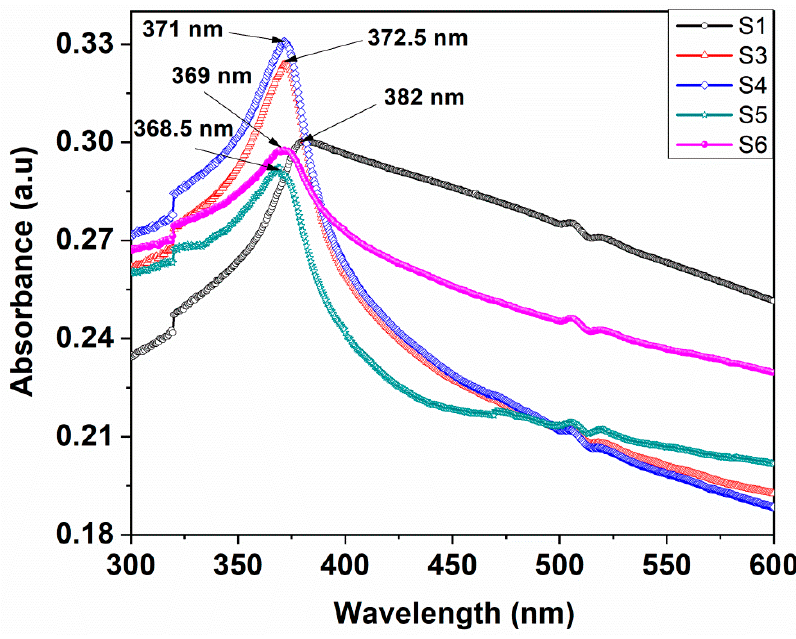
Figure 5. Absorption spectra of pure ZnO and ZnO-incorporated MoO 3 nanostructures with different atomic weight percentages of MoO 3 oxide.